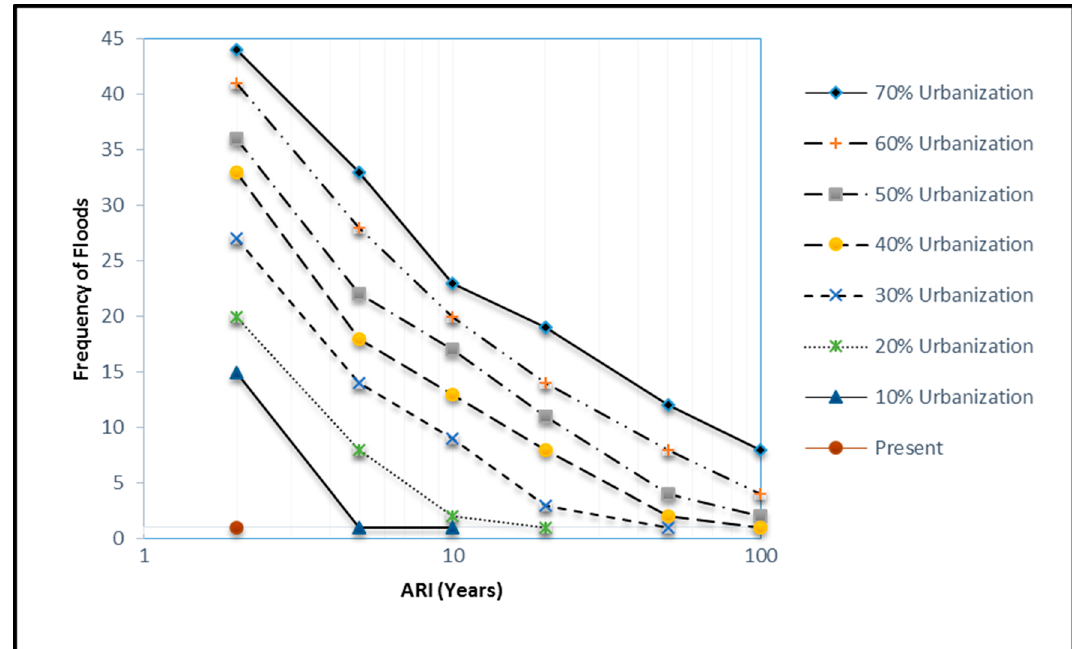
Figure 10. Effects of urbanization on flood frequencies in the Myponga catchment.